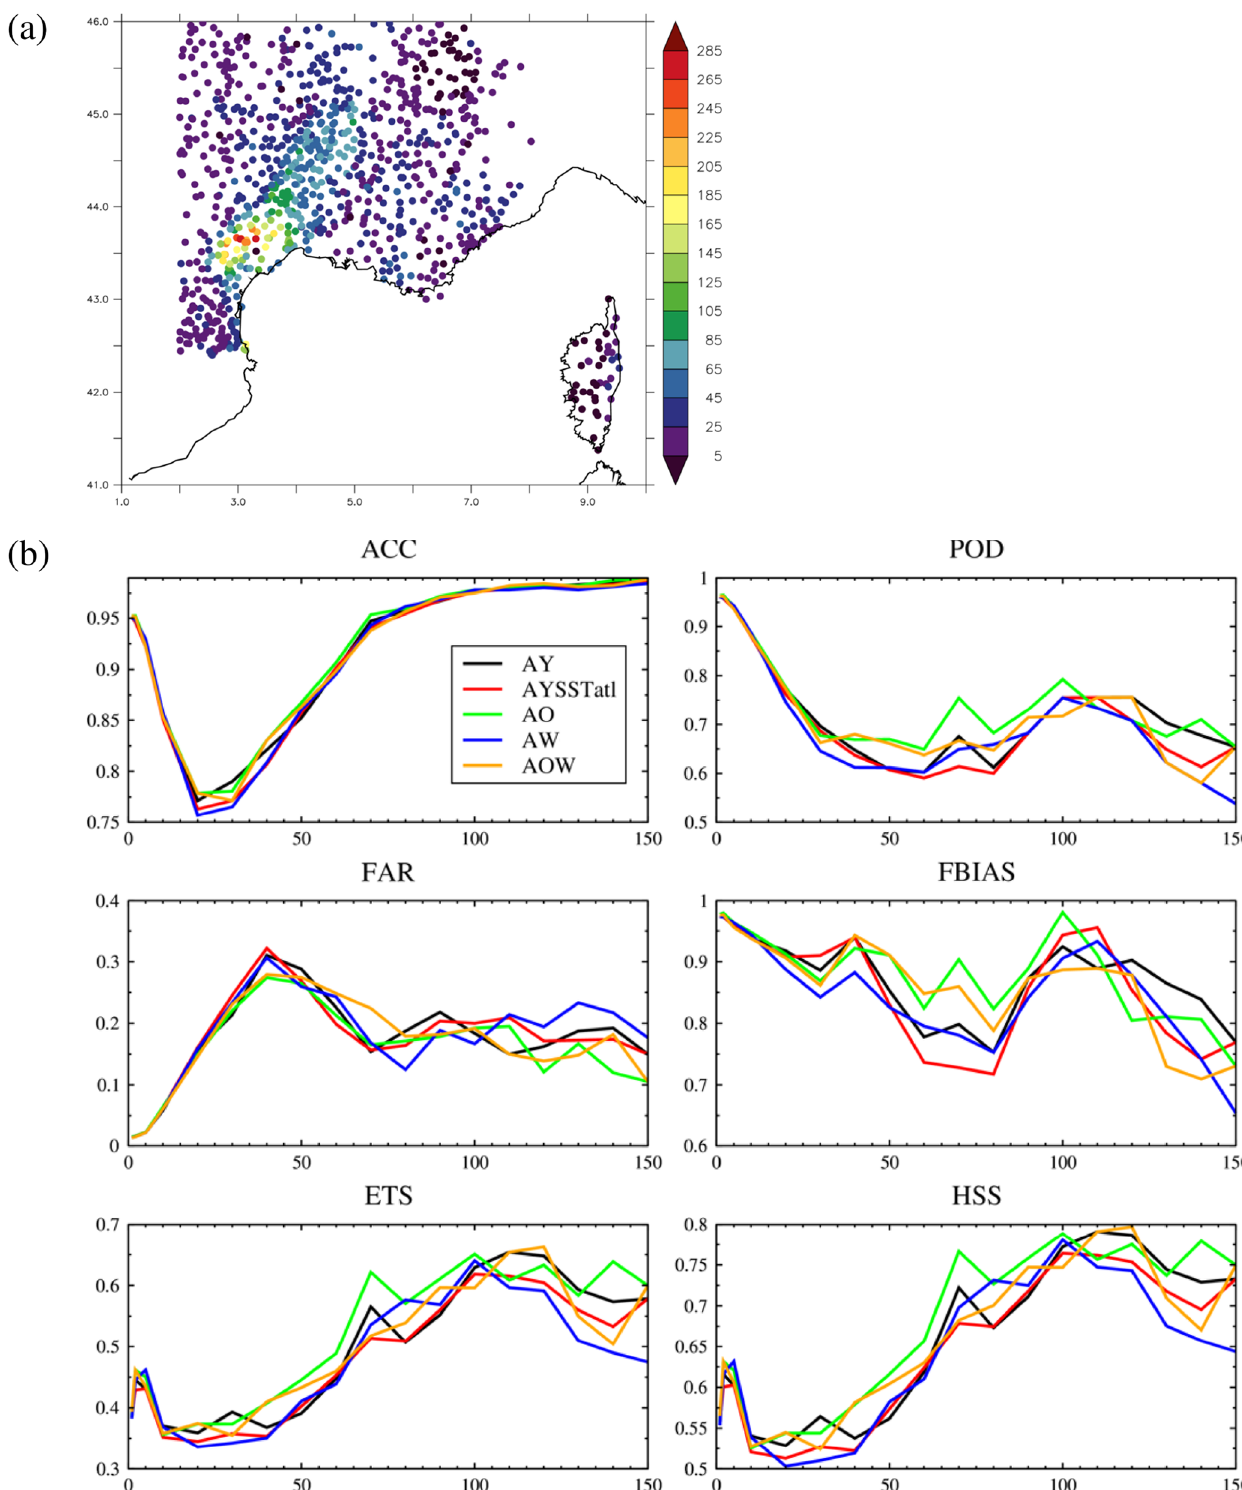
Figure 7. (a) Locations and measurements of 24h cumulative precipitation ( mm ) at 00:00UTC on 14 October of the Météo-France rain gauges over the southeastern quarter of France. (b) Forecast skill scores against rain-gauge observations calculated for cumulative rainfall in 24h at 00:00UTC on 14 October. The x axis indicates the rainfall threshold considered, in millimeters.